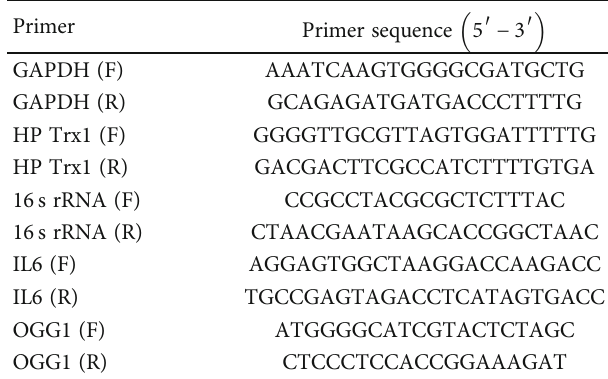
Table 1: The display of primer sequences used in the research.